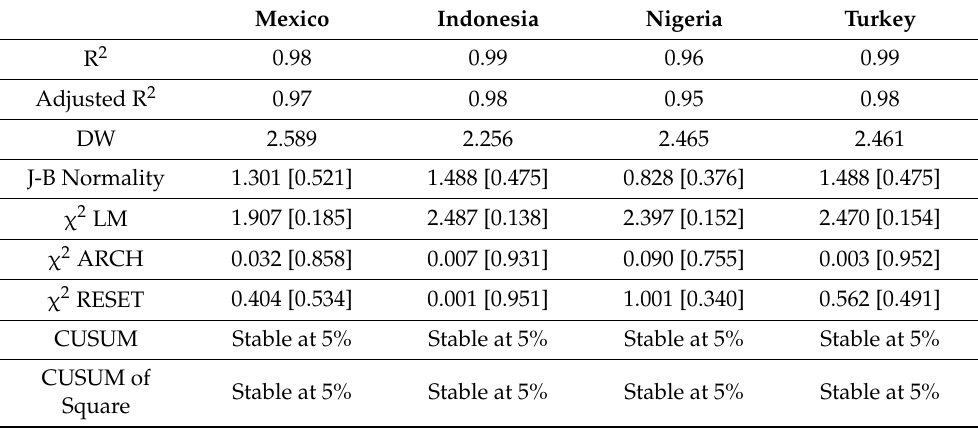
Table 7. Post Estimation